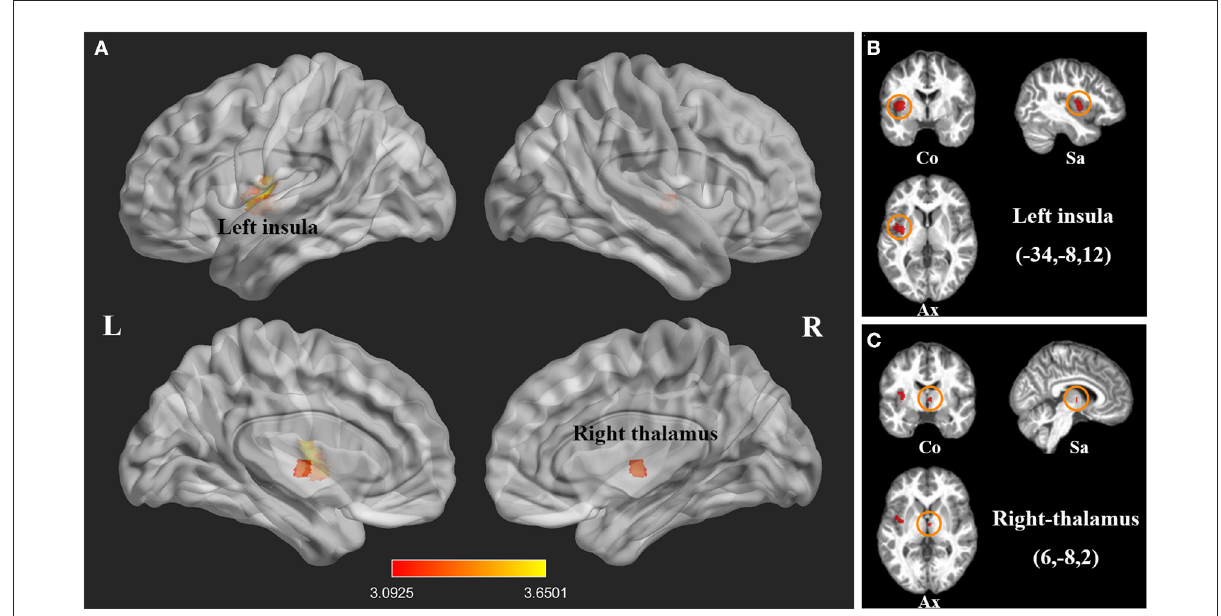
FIGURE2 Statistical parametric maps showing decreased gray matter volumes in patients with spinal cord injury (SCI) compared with those of healthy controls in the pooled meta-analysis. (A) The overlay of statistical parametric maps showing the decreased gray matter volume in left insula and right thalamus in SCI patients compared with healthy controls. (B) The illustration of the sagittal, coronal and axial planes of the decreased gray matter volume in left insula in SCI patients compared with healthy controls. (C) The illustration of the sagittal, coronal and axial planes of the decreased gray matter volume in right thalamus in SCI patients compared with healthy controls. Color bar represents t -value; Co, Sa, and Ax represent coronal, sagittal and axial planes, respectively. R, right; L left, spinal cord injury,